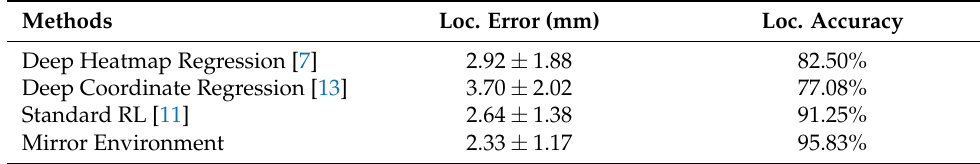
Table 2. Localization error and accuracy.